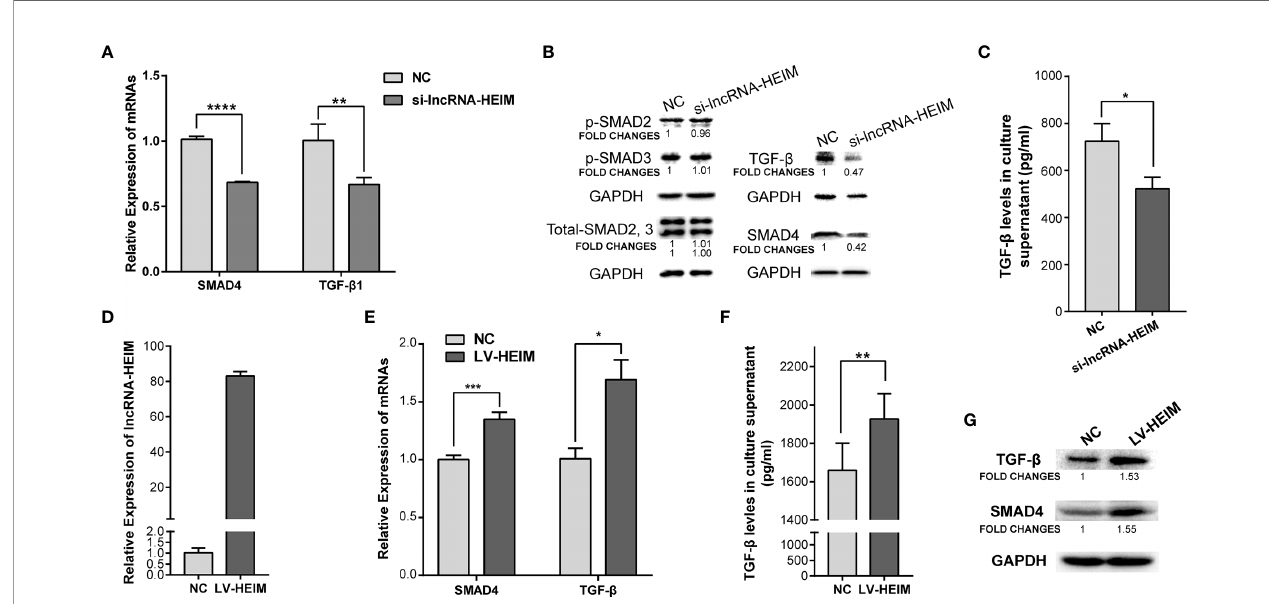
FIGURE 4 | Over-expression of lncRNA-HEIM remarkably promoted the expression of TGF- b and SMAD4. (A) Relative expression of SMAD4 or TGF- b in monocytes transfected with siRNAs for lncRNA-HEIM or negative control (NC). ∗∗ p < 0.01; ∗∗∗∗ p < 0.0001. (B) Western blotting assays of endogenous protein levels of TGF- b , SAMD4, phosphorylated SMAD2, 3, and total SMAD2, 3 in monocytes transfected with siRNAs for lncRNA-HEIM or NC. GAPDH protein levels were used as internal controls. Chemiluminescent densities were normalized with GAPDH, and fold changes were calculated based on NC. (C) ELISA based TGF- b levels in culture supernatant of monocytes transfected with siRNAs for lncRNA-HEIM or NC. ∗ p < 0.05. (D) Relative expression of lncRNA-HEIM in monocytes infected with lncRNA-HEIM lentivirus (LV-HEIM) or negative control (NC). (E) Relative expression of TGF- b or SMAD4 in monocytes stably over-expressing lncRNA-HEIM or NC. ∗ p < 0.05; ∗∗∗ p < 0.001. (F) ELISA based TGF- b levels in culture supernatant of monocytes with LV-HEIM or NC. ∗∗ p < 0.01. (G) Western blotting assays of endogenous protein levels of TGF- b , SAMD4 in monocytes with LV-HEIM or NC. Fold changes, same as